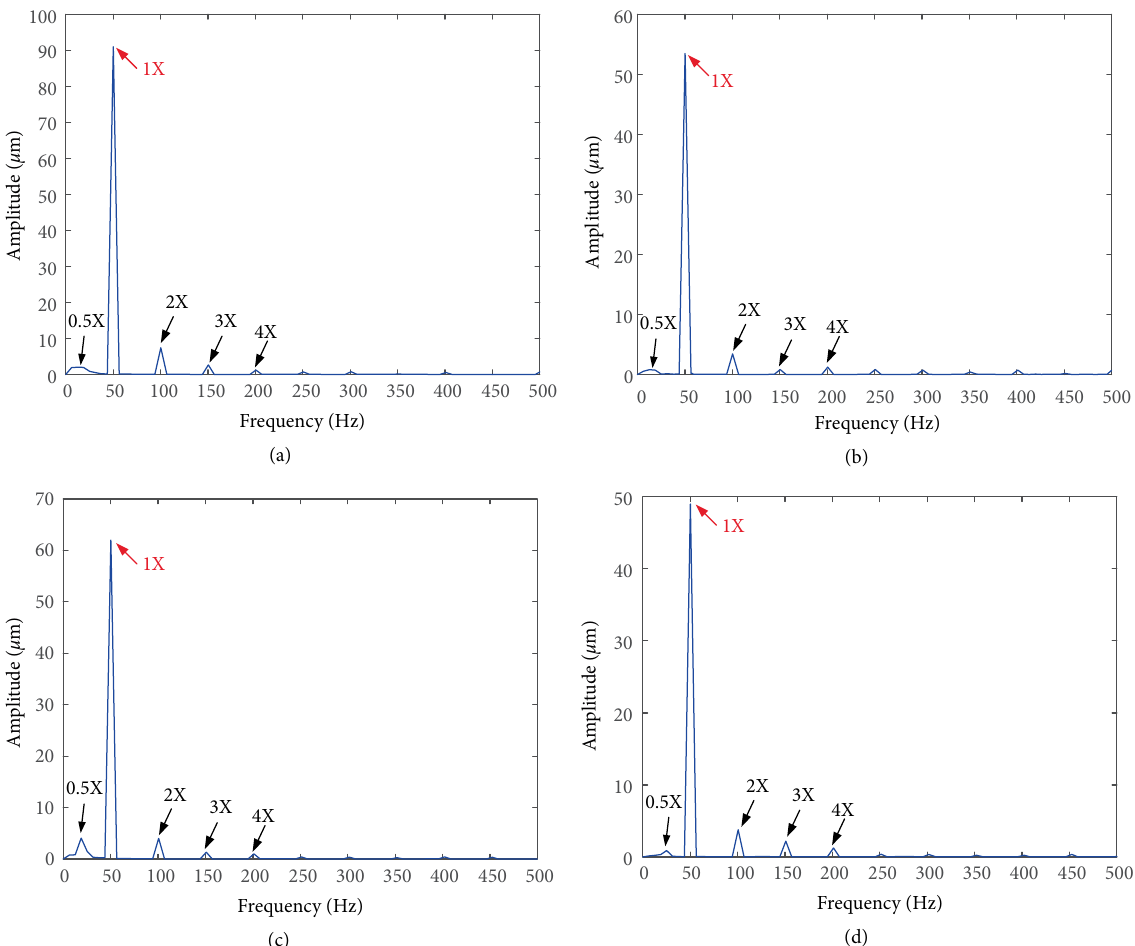
Figure 9: Vibration frequency spectrum. (a) х -direction at bearing A. (b) y -direction at bearing A. (c) х -direction at bearing B. (d) y -direction at bearing B . coefficients for measuring points, the trial